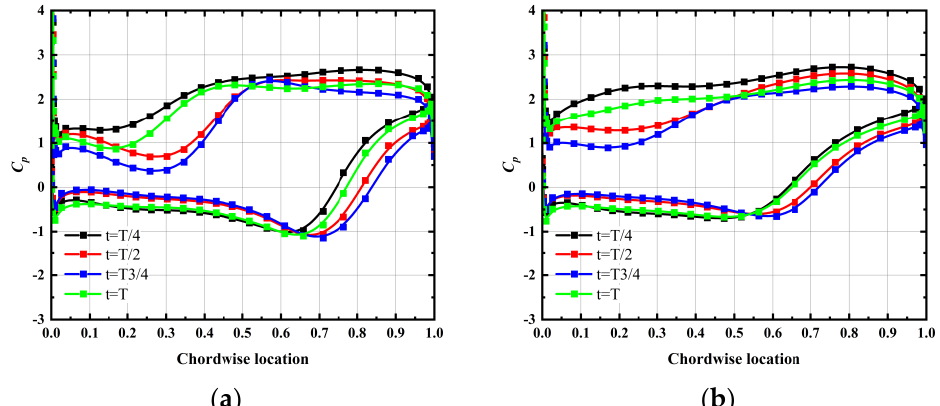
Figure 20. Blade loading distribution at different circumferential locations (95% spanwise). ( a ) DIS case; ( b ) COUP case. case; ( b ) COUP